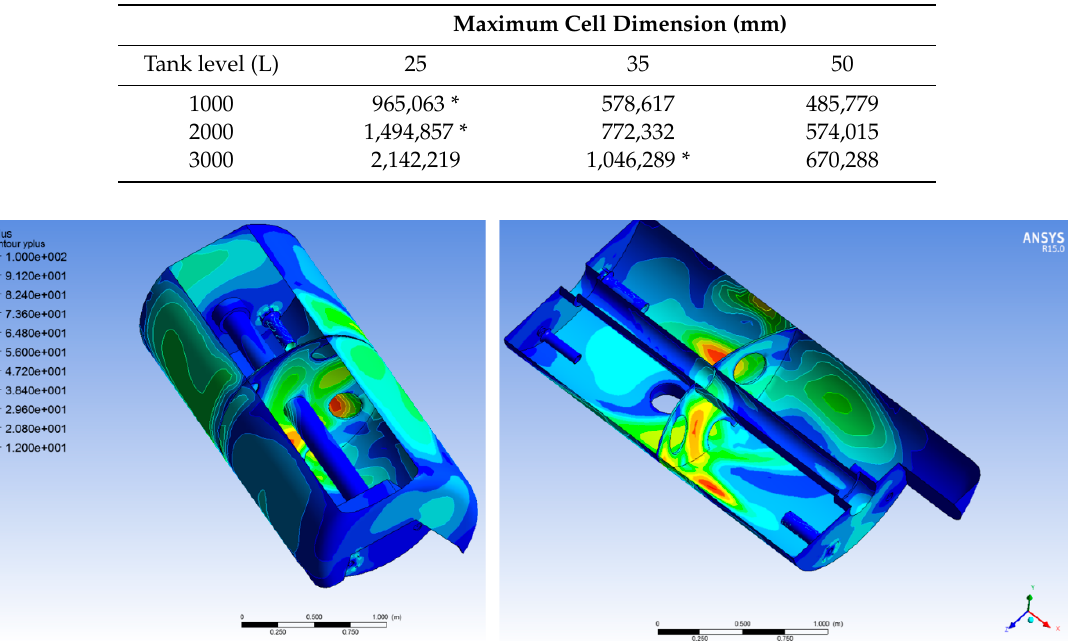
Table 2. Characteristics of the CFD meshes studied previously (2 nozzles, 10 bar). * Meshes finally developed in the numerical model selected.